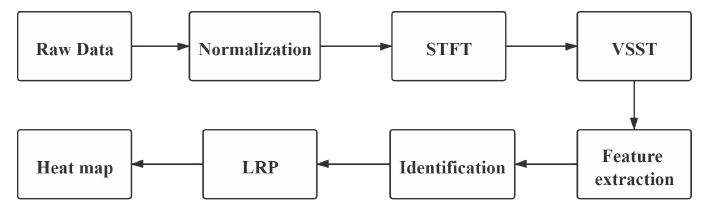
Figure 10. Flowchart of data processing.